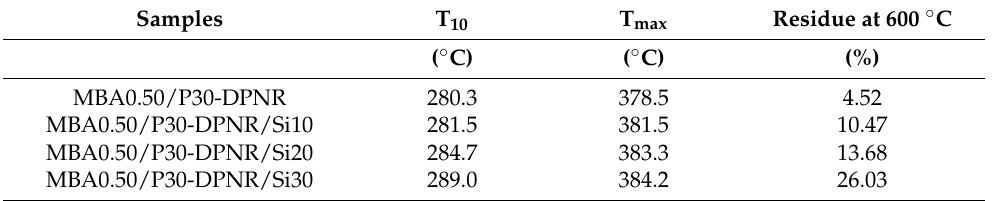
Figure 9. TGA and DTG thermograms of M0.50/P30-DPNR and M0.50/P30-DPNR/silica composites with various silica contents. Table 2. Thermal properties of M0.50/P30-DPNR/silica composites with various silica contents.